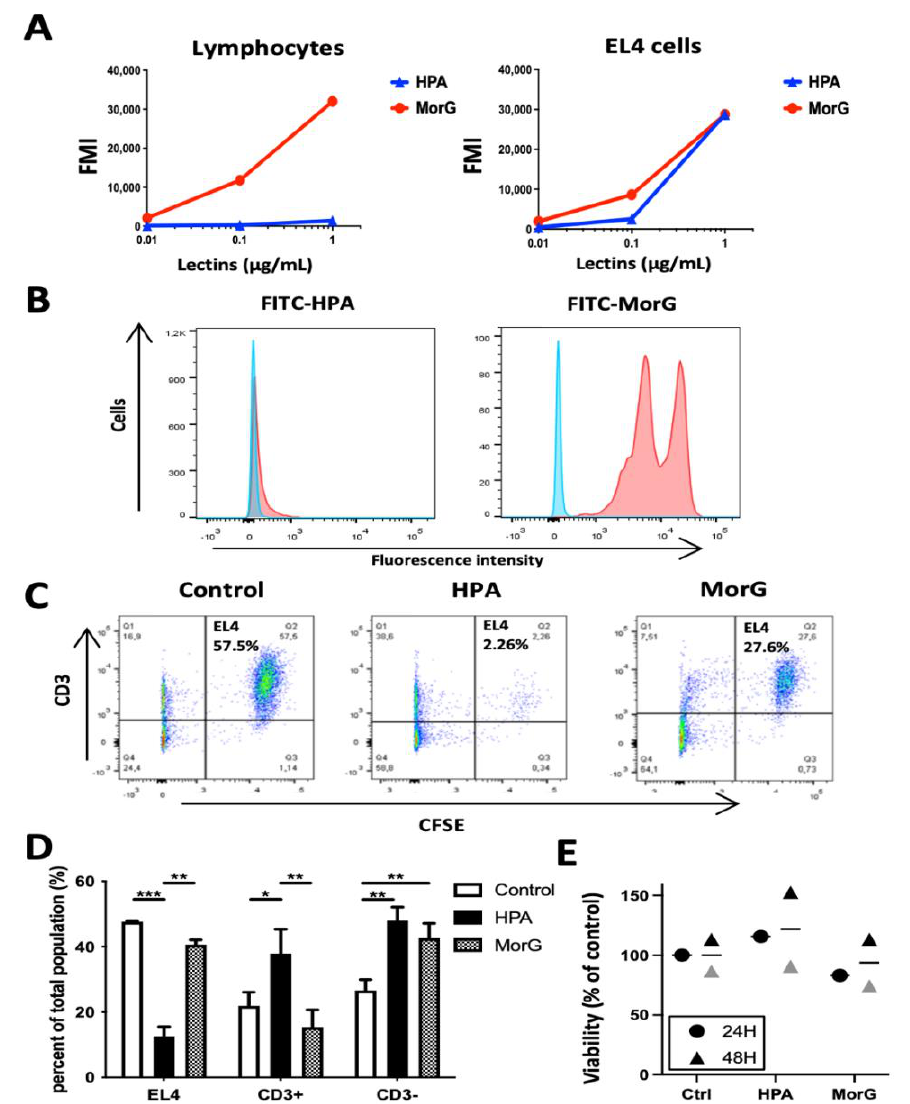
Figure 3. HPA induces a discriminative toxicity on EL4 tumor cells: ( A , B ) Non-adherent splenocytes from healthy mice (lymphocytes) or EL4 lymphoma cells were labeled by increasing concentrations of FITC-conjugated HPA (FITC-HPA) or FITC-conjugated Morniga G (FITC-MorG) and analyzed using cytofluorimetry. ( B ) Representative staining of healthy lymphocytes using 1 µ g/mL FITC-HPA or FITC- MorG. ( C , D ) Mixture (1:1) of healthy lymphocytes and CFSE-labeled EL4 lymphoma cells were cultured for 48 h in the presence of 20 µ g/mL HPA or MorG, washed and then incubated with PE-labelled anti-CD3 mouse monoclonal antibody and analyzed using cytofluorimetry: ( C ) representative experiment and ( D ) means of three independent experiments. ( E ) Lymphocytes from healthy mice were incubated for 24–48 h with 20 µ g/mL HPA or MorG, then cell viability was evaluated using cytofluorimetry. Rounds and triangles are means of three to four mice. Horizontal lines are means of the two independent experiments after 48 h cultures. Significant differences are indicated (* p < 0.05; ** p < 0.01; *** p < 0.001) .